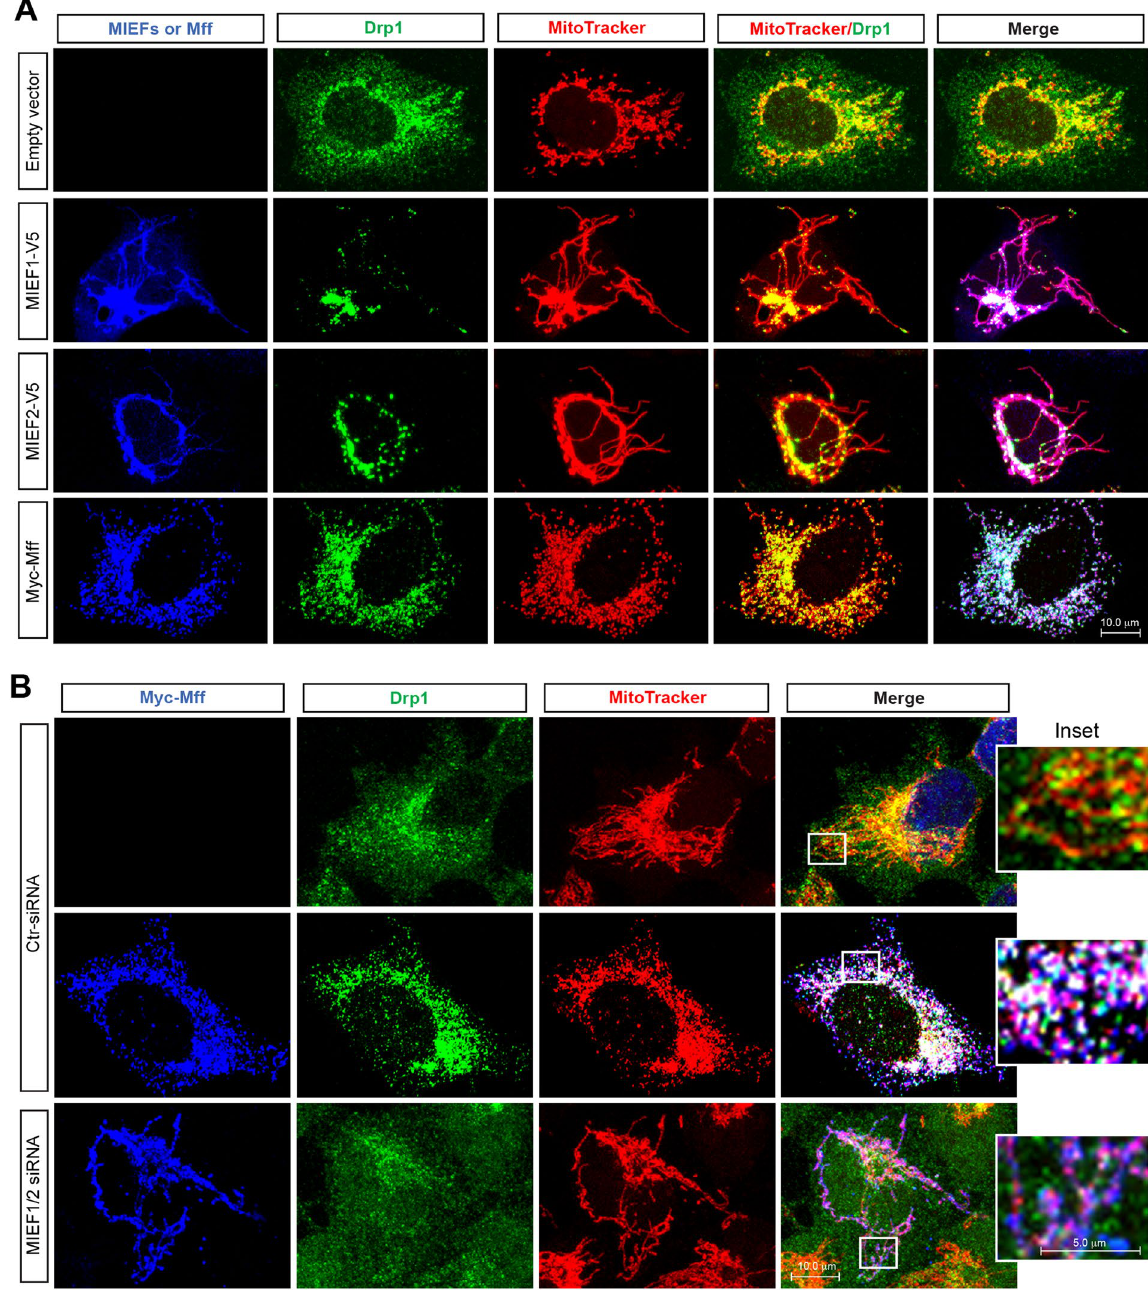
Figure 1. MIEFs and Mff recruit Drp1 to mitochondria, but have opposing effects on mitochondrial morphology. (A) Overexpression of either MIEF1, MIEF2 or Mff recruits Drp1 from the cytoplasm to mitochondria, but MIEF overexpression leads to a mitochondrial fusion phenotype, while Mff induces mitochondrial fission. Confocal images of mitochondrial morphology and Drp1 distribution in 293T cells transfected with indicated plasmids, stained with MitoTracker (red), anti-Drp1 (green), and either anti-V5 (blue for MIEF) or anti-Myc (blue for Mff) antibodies. (B ) Confocal images of 293T cells treated with control siRNA or a combination of MIEF1 and MIEF2 siRNAs, followed by transfection with empty vector or Myc- Mff plasmid, and stained with MitoTracker (red), anti-Drp1 (green) and anti-Myc (blue) antibodies. Insets represent high magnification views of the boxed areas. Results from quantitative co-localization of Drp1 with mitochondria are summarized in Fig.